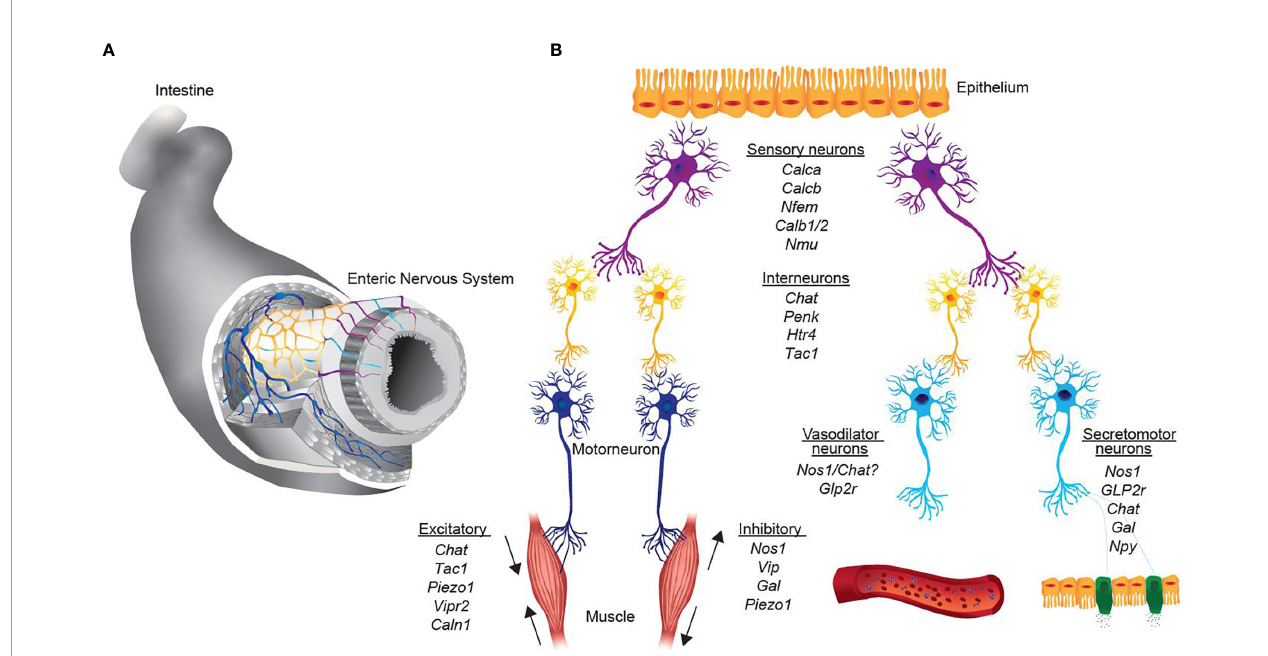
FIGURE 1 | Representation of neurons, key transcripts and functional assignments in the intrinsic enteric nervous system. (A) 2-Dimensional scheme of the enteric nervous system. Colors represent the schematic representation of distinct functional neuronal groups. (B) Simpli fi ed representation from sensing of the environment of different stimuli (sensory neurons, purple), signaling transmission to interneurons (yellow) and excitation of effector neurons (motor neurons, dark blue; vasodilator and secretomotor, light blue). Italics are the key transcripts of the respective neuronal